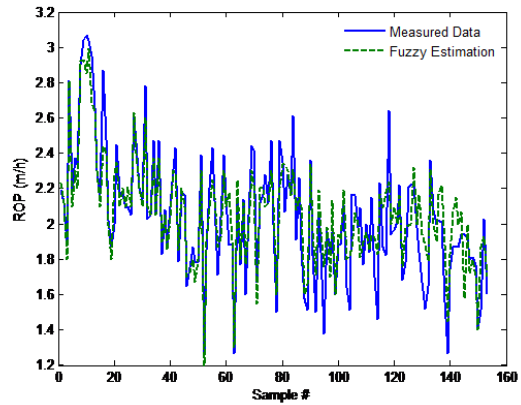
Figure 11: Fuzzy logic model estimation.